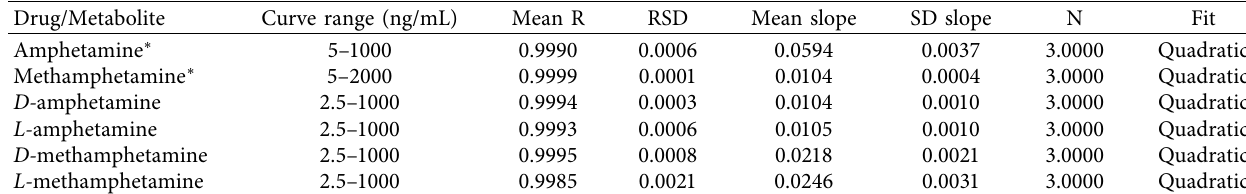
Table 3: Statistical analysis for each analyte standard curve over three assays.